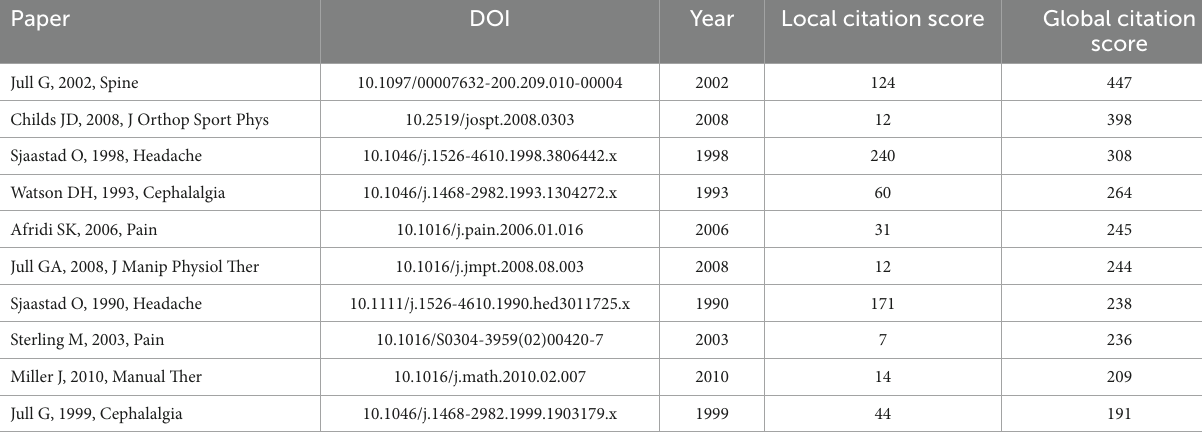
TABLE 6 Top 10 papers with the highest global citation score.